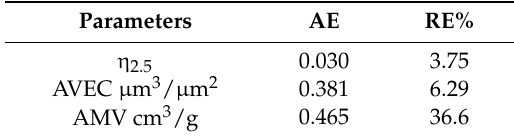
Table 4. Median absolute error (AE) and the corresponding relative error (RE) of three estimation